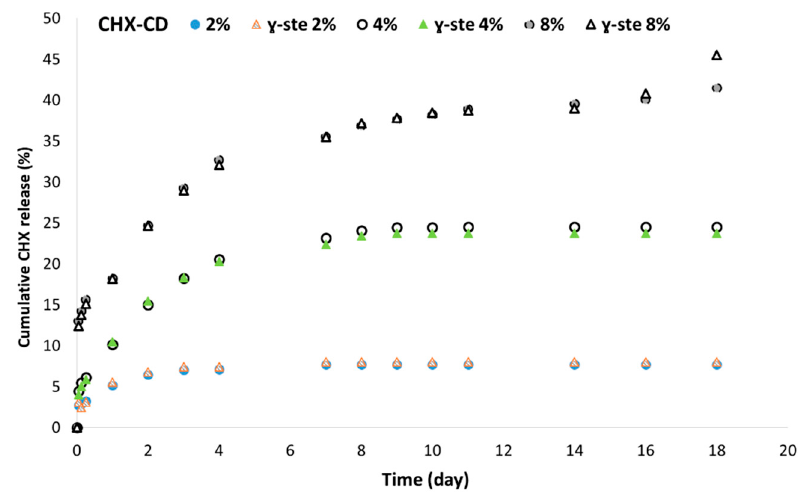
Figure 5. Cumulative CHX release according to the CHX loading with the formulation PLGA / PLC / CHX-CD (60:40) before and after sterilization by γ -irradiation, measured by UV spectrometry.